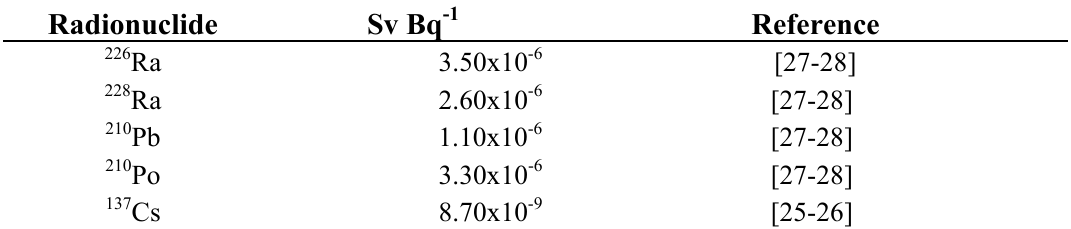
Table 2. Dose conversion factors for inhalation for